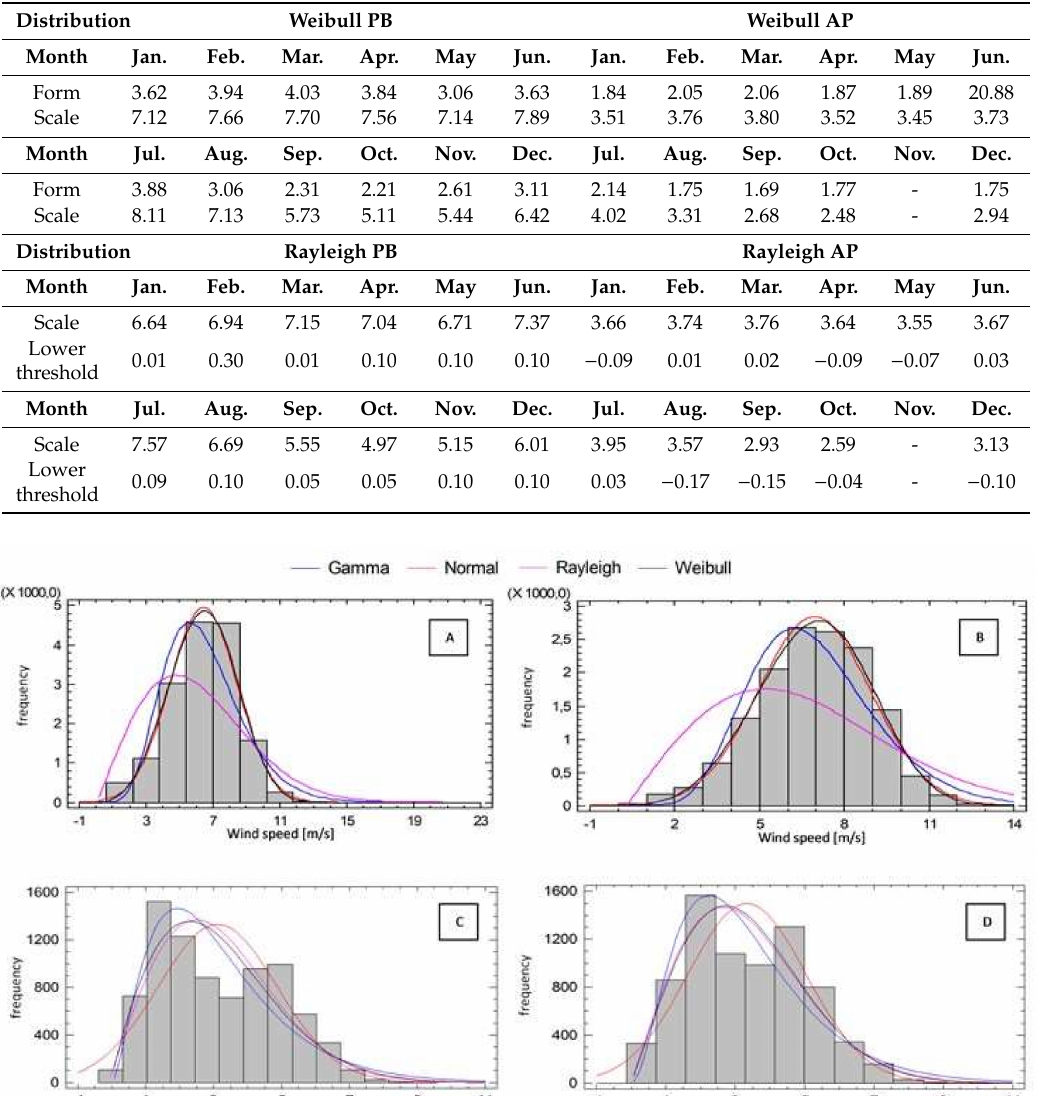
Table 4. Multi-annual adjusted distributions of wind speed for Puerto Bolivar (PB) and Almirante Padilla (AP), from 2003 to 2013 [22].